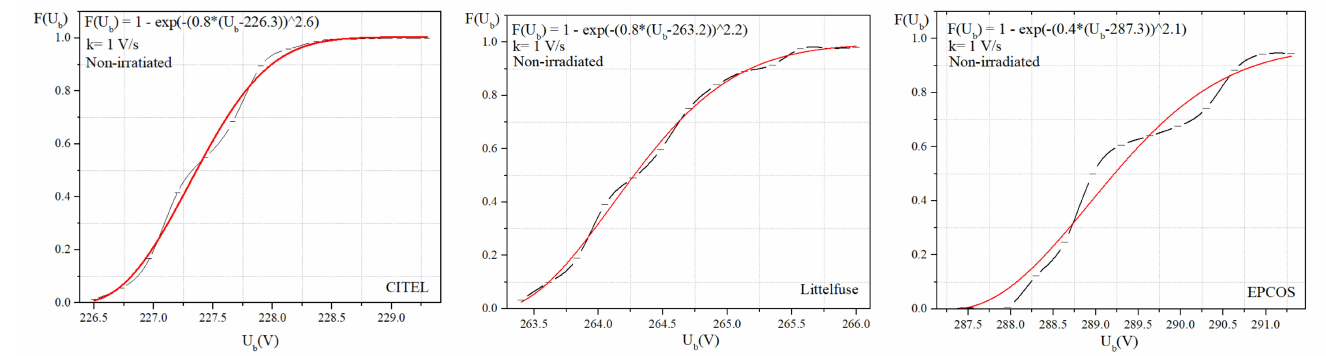
Figure 10. Cumulative distribution functions of non-irradiated CITEL, Littelfuse and EPCOS GFSAs, respectively, for increase voltage rates k = 1